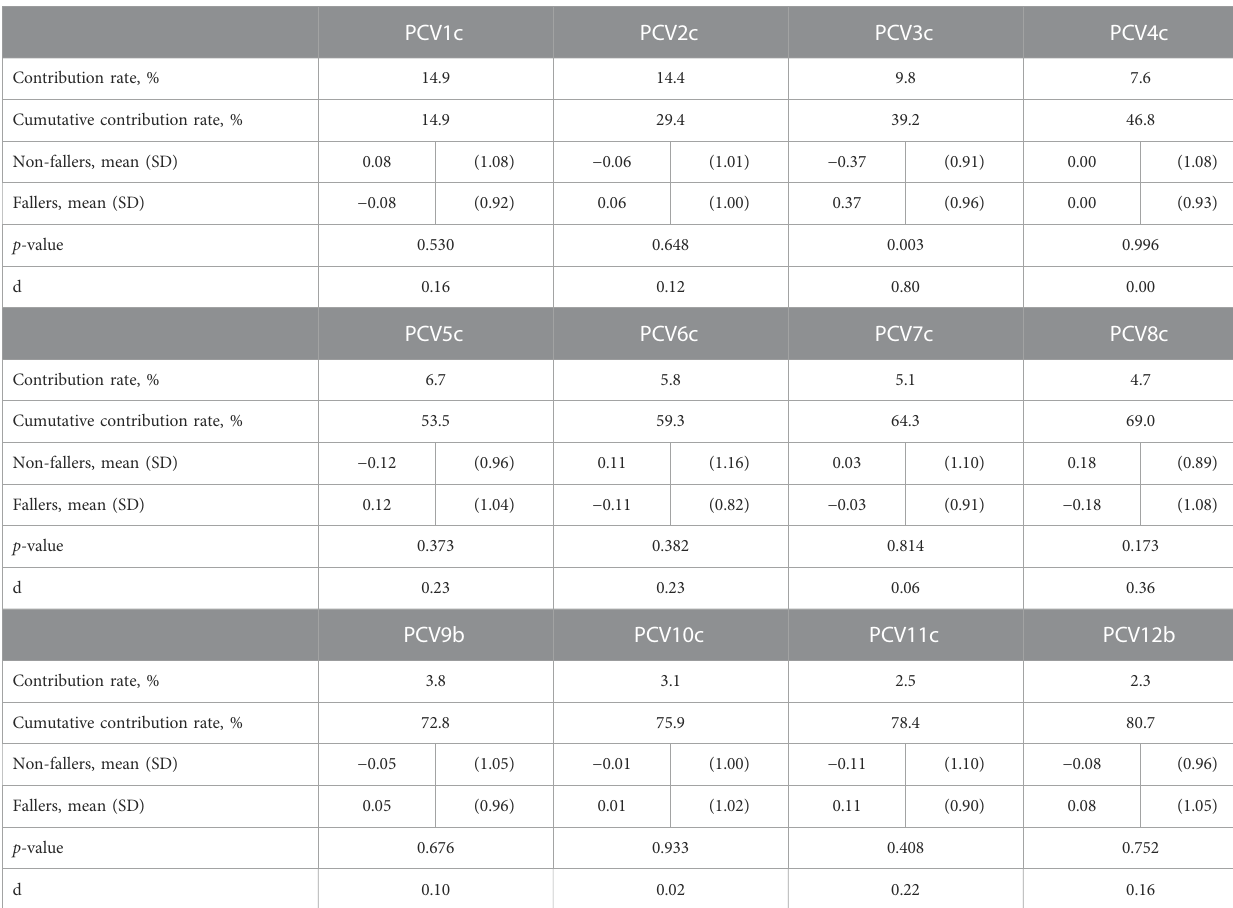
TABLE 1 Results of